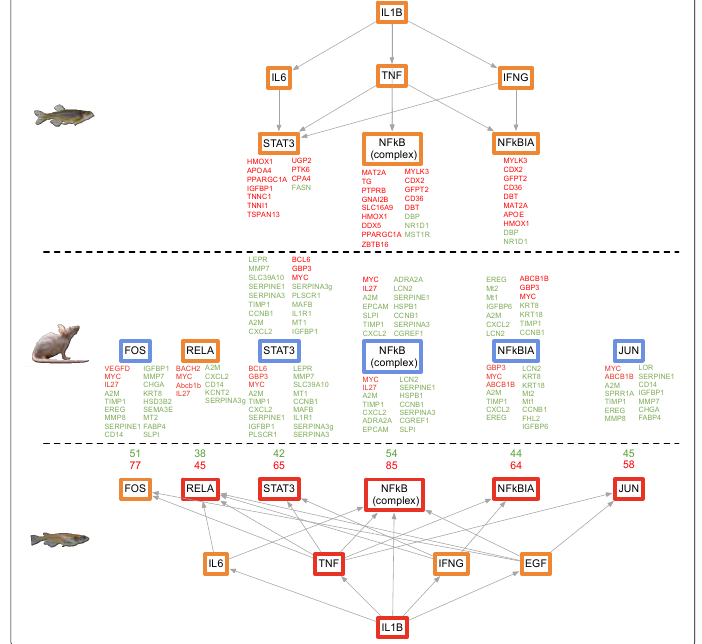
Figure 6. IL1B controls expression of many shared mid-level regulators in the zebrafish (top), medaka (bottom), and mouse (middle) liver datasets, including the key immune and inflammation APR regulator TNF . Genes in red and green are modulated DEGs, and genes in orange and blue are predicted by IPA to be up and down, respectively. Due to the robust dataset in medaka, the number of genes up and down-modulated are listed in red and green,